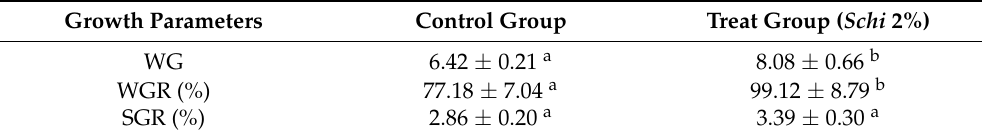
Note: Values were the mean ± SEM of five replicates, and values in the same row with different letters were significantly different ( p < 0.05). Schi represents Schizochytrium